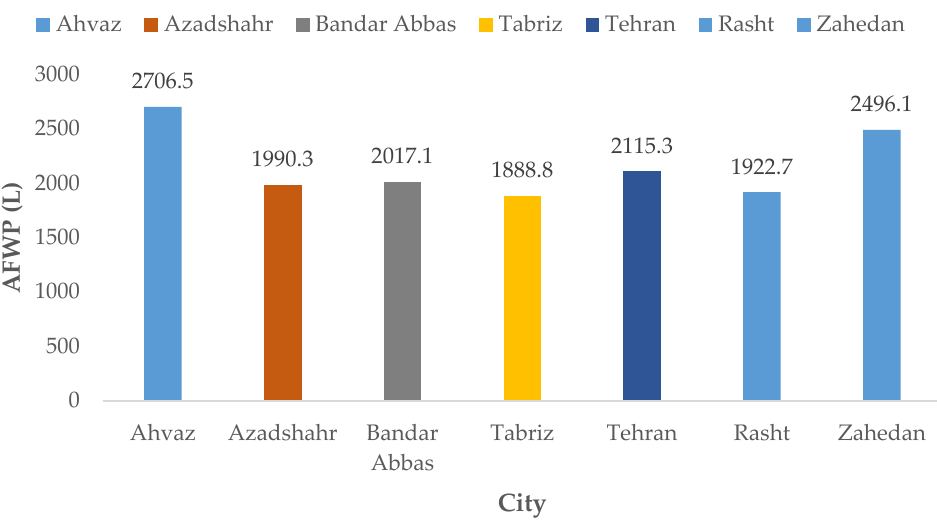
Figure 5. Comparing AFWP for seven investigated cities.